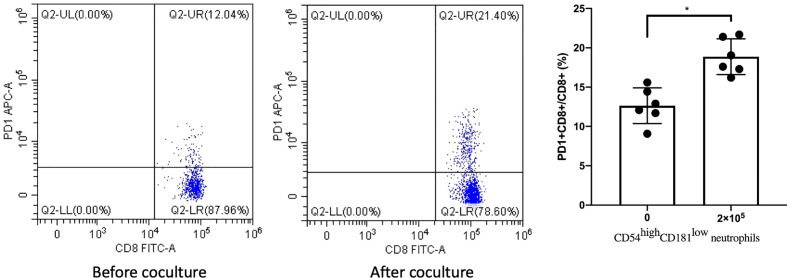
CD54highCD181low neutrophils from myelodysplastic syndromes (MDS) patients (n = 6) lead to upregulation of PD1 expression on CD8+ T cells. The bars represent the standard error of the mean. *P < 0.05.